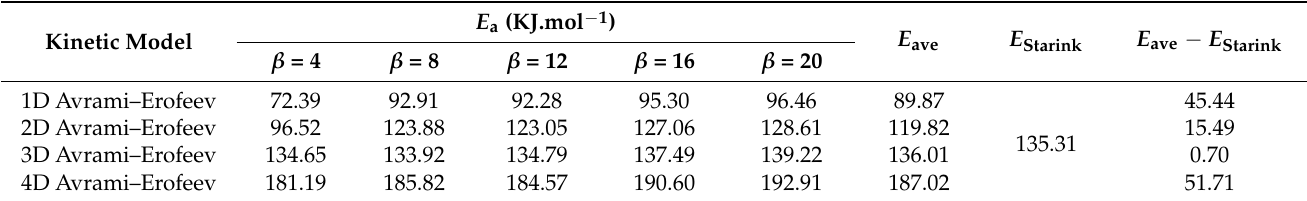
Table 5. Activation energies E a and average E a values E ave of the steam gasification reaction of char obtained using the various Avrami–Erofeev models at different heating rates β (K · min − 1 ). The E ave value obtained using the Starink method is also given as E Starink .